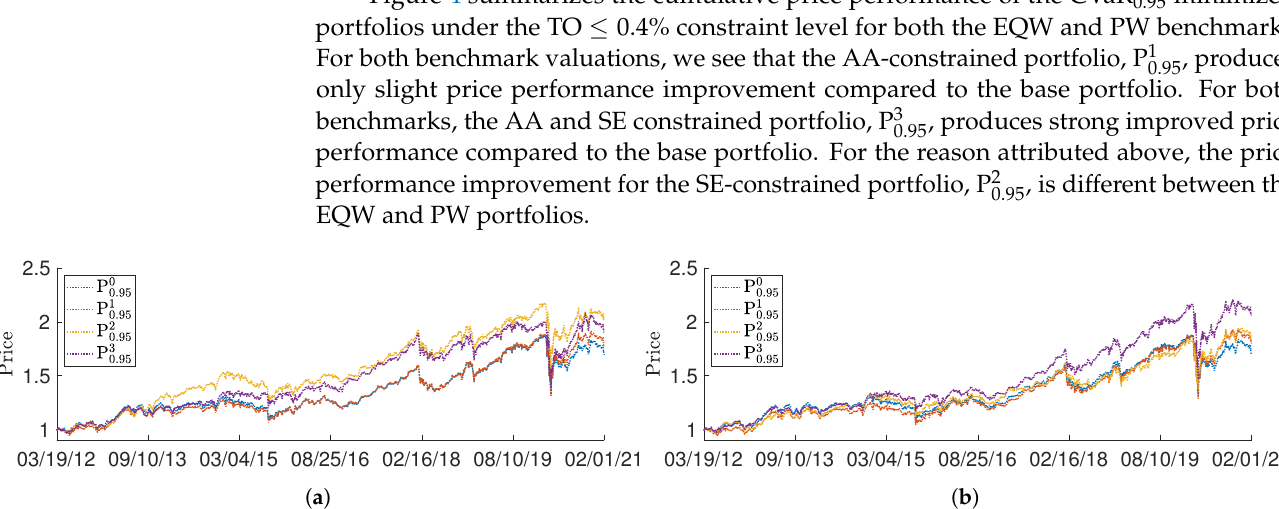
Figure 4. Cumulative price performance of the CVaR 0.95 minimized portfolios under the TO ≤ 0.4% constraint level; ( a ) equi-weighted benchmark, ( b ) price-weighted